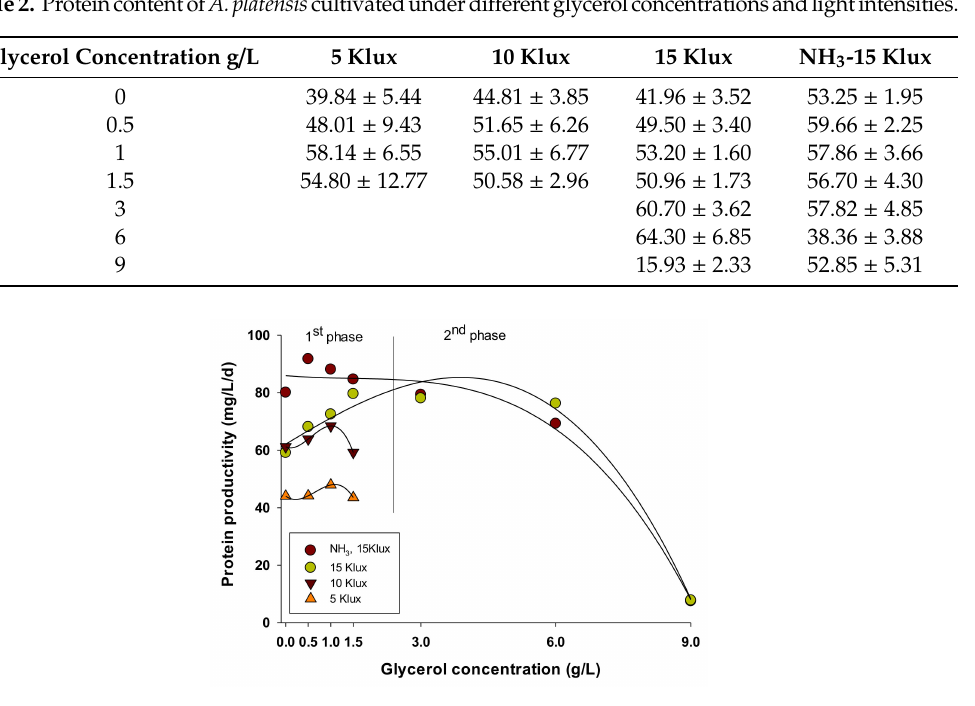
Figure 2. Protein productivity of A. platensis cultivated under di ff erent glycerol concentrations and light